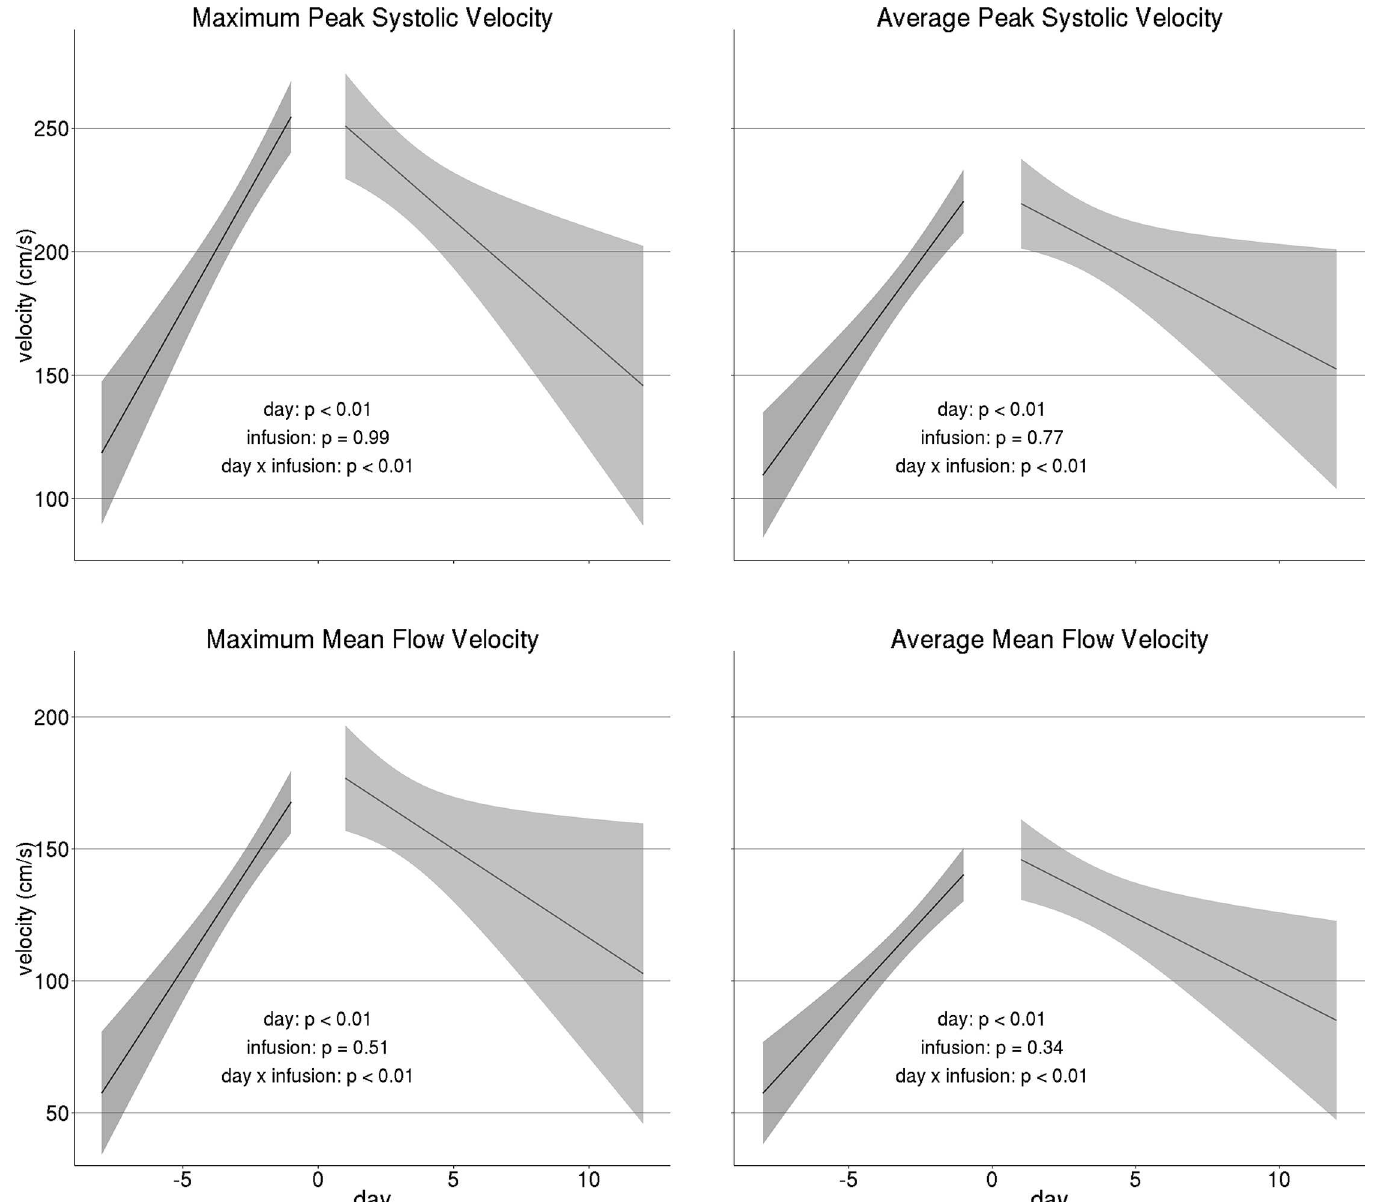
Fig 2. Trends in MCA Blood Flow. Trends in TCD measuresof middlecerebralblood flow before and after intra-arterial infusion (day 0) across days. Shadedareas denote95% confidenceintervals. Strong day x infusion interaction indicates a significantreversalin trend after infusion.